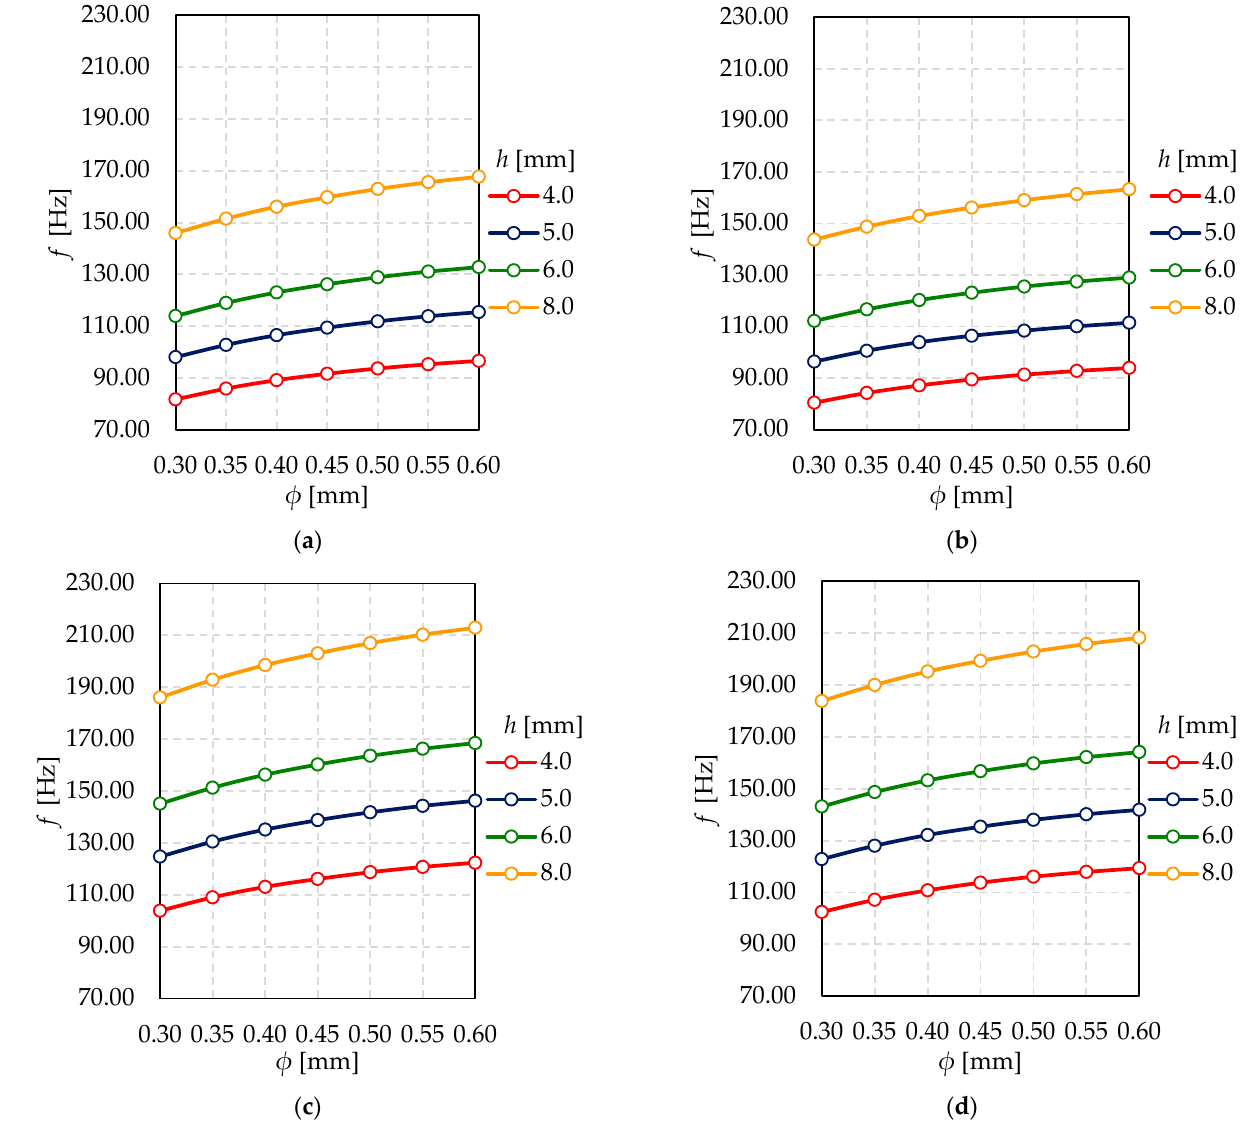
Figure 15. The relationship between natural frequency ( f ) and support pillar diameter ( φ ) for different glass thickness—( a ) mode shape n = 1 and x 0 = y 0 = 50 mm; ( b ) mode shape n = 1 and x 0 = y 0 = 100 mm; ( c ) mode shape n = 2 and x 0 = y 0 = 50 mm; ( d ) mode shape n = 2 and x 0 = y 0 = 100 mm.